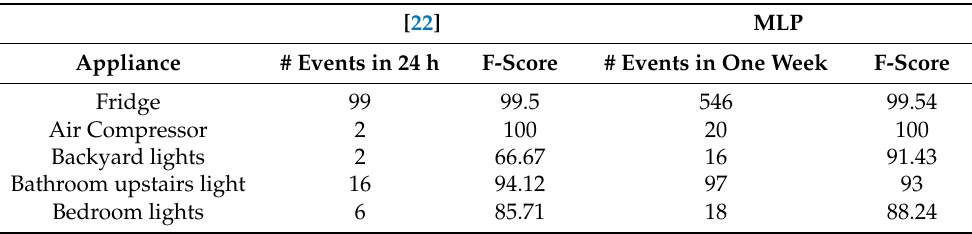
Table 6. Comparison with the performance reported in [22] for five appliances of BLUED.